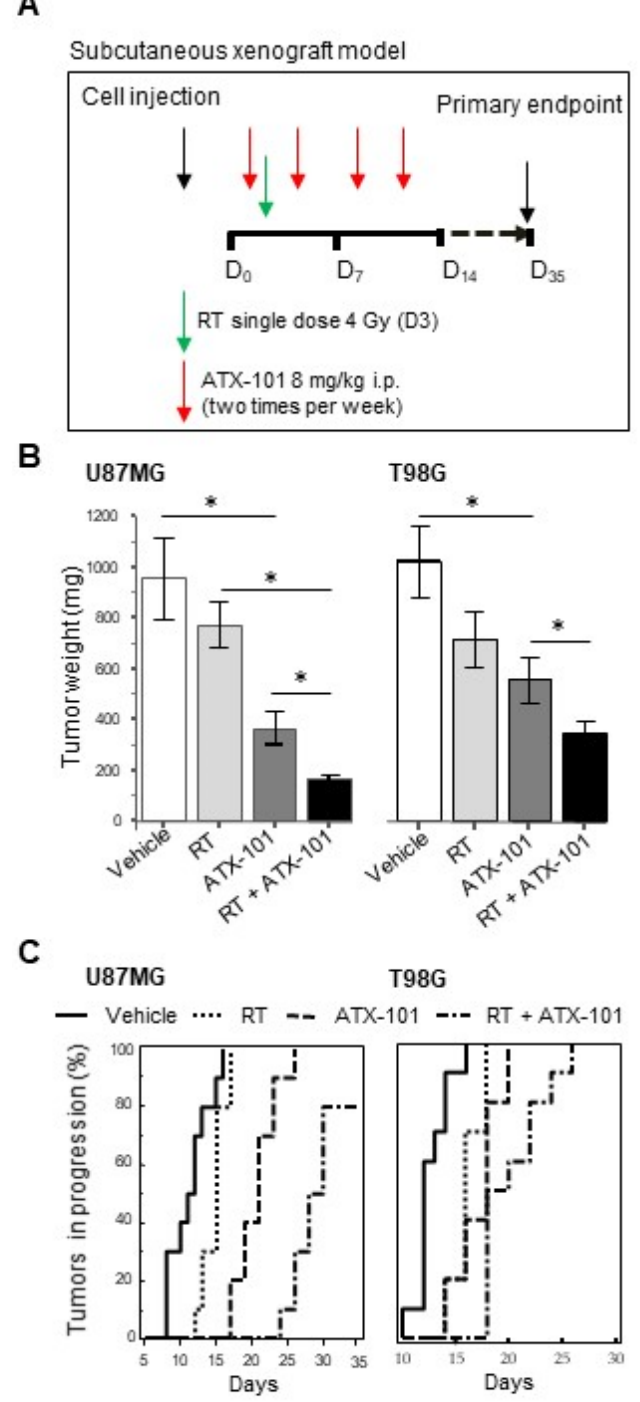
Figure 7. ATX-101 reduces the growth of subcutaneous xenograft GBM tumors. ( A ) Treatment scheme: 5 animals in each group received subcutaneous flank injections (2 tumors per mice). Vehicle or ATX-101 (8 mg/kg) were administered intraperitoneally (i.p.) two times per week (D2, D5, D9, D12, D16, D19, D23, D26, D30, and D33); radiotherapy (RT) (4 Gy) was given as a single administration on D3. ( B ) Weight of tumors collected from mice injected with U87MG (MGMT negative cells) and T98G cells (MGMT-positive tumor cells) at day 35 after treatment start. * p < 0.01. ( C ) Percentage of tumors in progression/Kaplan–Meier curves for the same xenografts as in B. Statistics are shown in Supplementary Table S3.